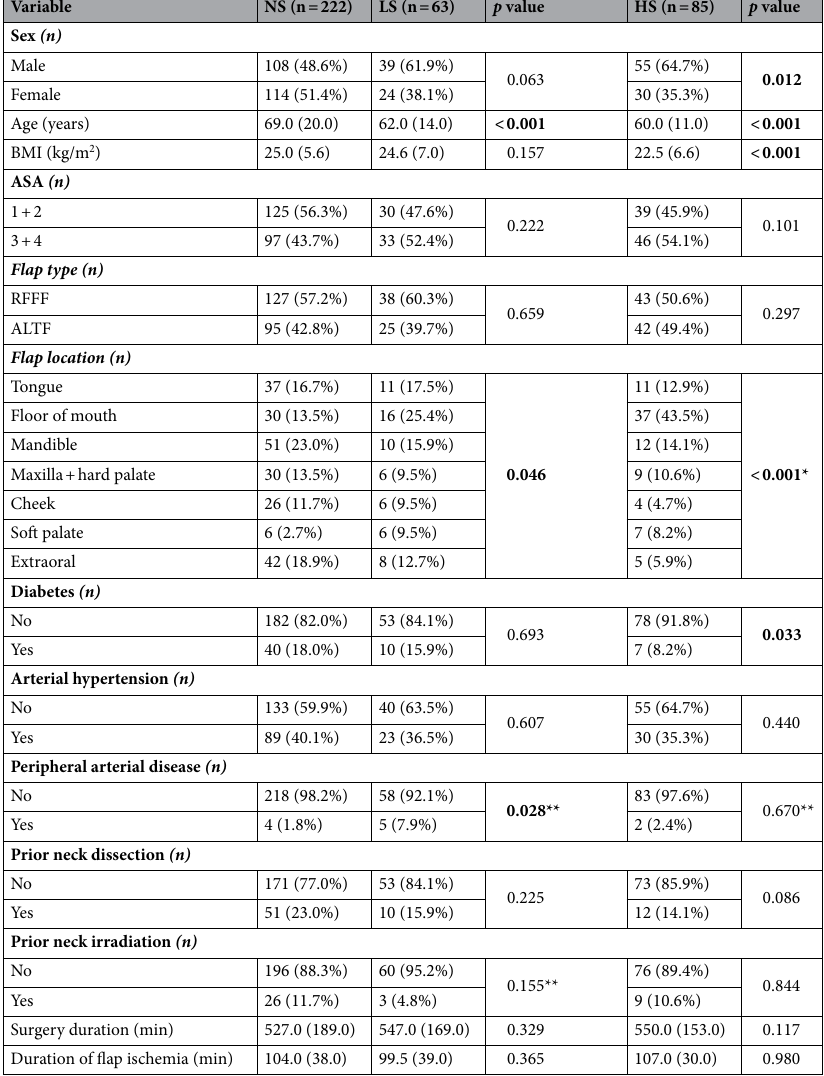
Comparison of clinical parameters between groups. The study population consisted of 370 patients: 222 nonsmokers, 63 light smokers, and 85 heavy smokers (Table 1). The light smokers and nonsmokers showed differences in age ( p < 0.001), peripheral arterial disease ( p = 0.028), and flap location ( p = 0.046) (Table 1). The heavy smokers and nonsmokers showed differences in sex ( p = 0.012), age ( p < 0.001), BMI ( p < 0.001), diabetes ( p = 0.033), and flap location ( p < 0.001) (Table 1). The flap revision rates were similar in light smokers and heavy smokers when separately compared with non- smokers for all flaps (6.3% vs. 5.4%, p = 0.760; and 5.9% vs. 5.4%, p = 1.000), for RFFFs (5.3% vs. 6.3%, p = 1.000; and 9.3% vs. 6.3%, p = 0.501), and for ALTFs (8.0% vs. 4.2%, p = 0.603; and 2.4% vs. 4.2%, p = 1.000) (Table 2).